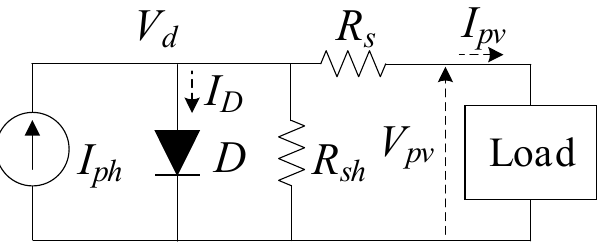
Figure 5. Equivalent circuit of the PV cell used to validate the experimental results.